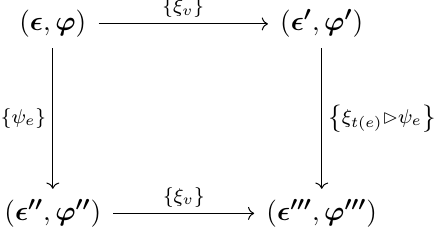
} coincides with { ψ 0 e